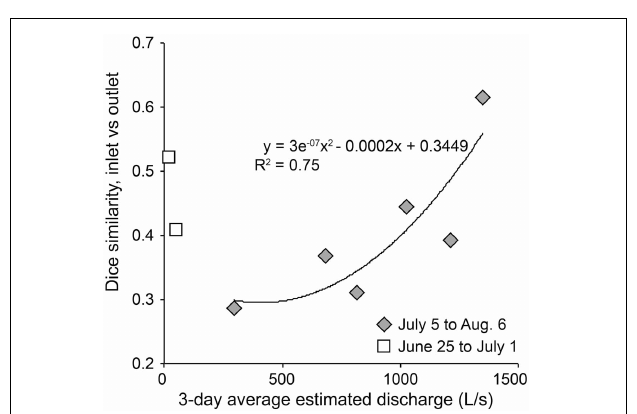
FIGURE 5 | Modeled discharge at I-8 inlet (black line) and % similarity of bacterial communities at I-8 inlet and I-8 outlet in the summer of 2003 (gray bars). Discharge was modeled using the relationship of discharge between Toolik Lake inlet and I-8 inlet in 2005–2007. Highest DNA similarity between I-8 inlet and outlet was detected after a large rain event near the end of July.